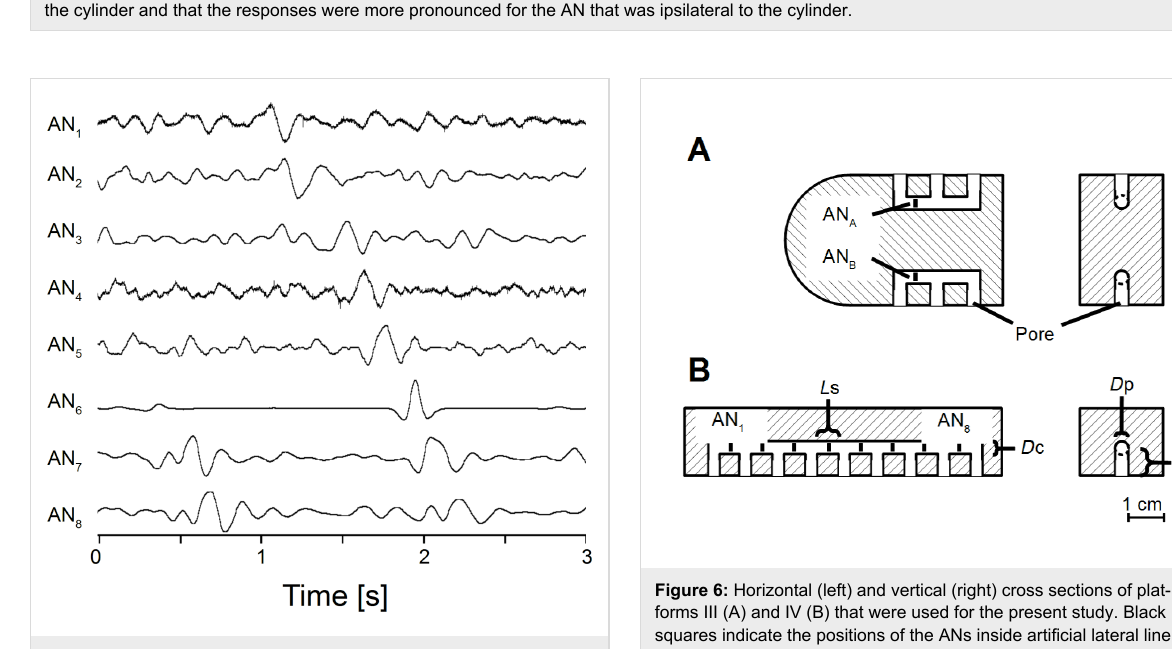
Figure 5: Responses of AN 1 to AN 8 (cf. Figure 6B) to bulk water flow. Note that the most prominent peak visible in the response of AN 1 is systematically delayed from AN 1 to AN 8 . The curves are not to scale due to the manual fabrication of each AN.